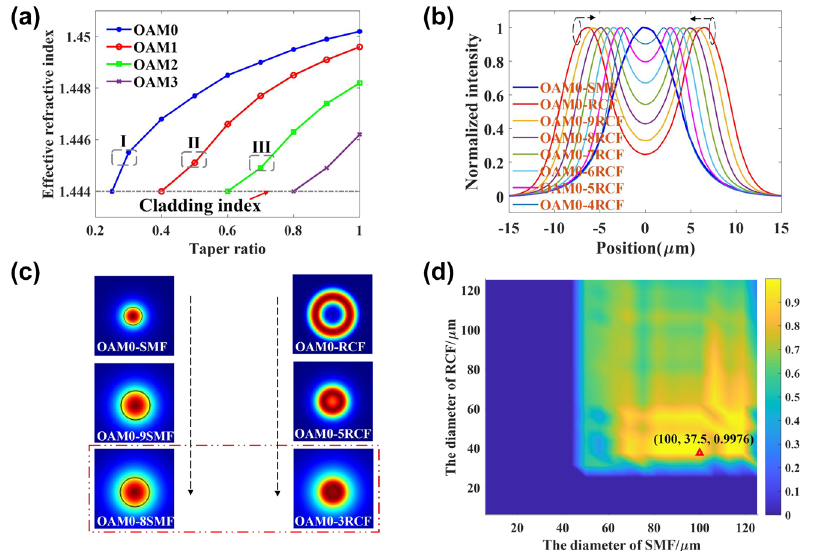
Figure 2: The simulation results. (a) The refractive index variation of each order mode in the tapered RCF. (b) The normalized intensity profile of the fundamental mode in SMF and (tapered) RCF. (c) Fundamental mode evolution in two tapered fibers. (d) The relationship between the fundamental mode coupling efficiency and the diameter of the SMF and RCF.